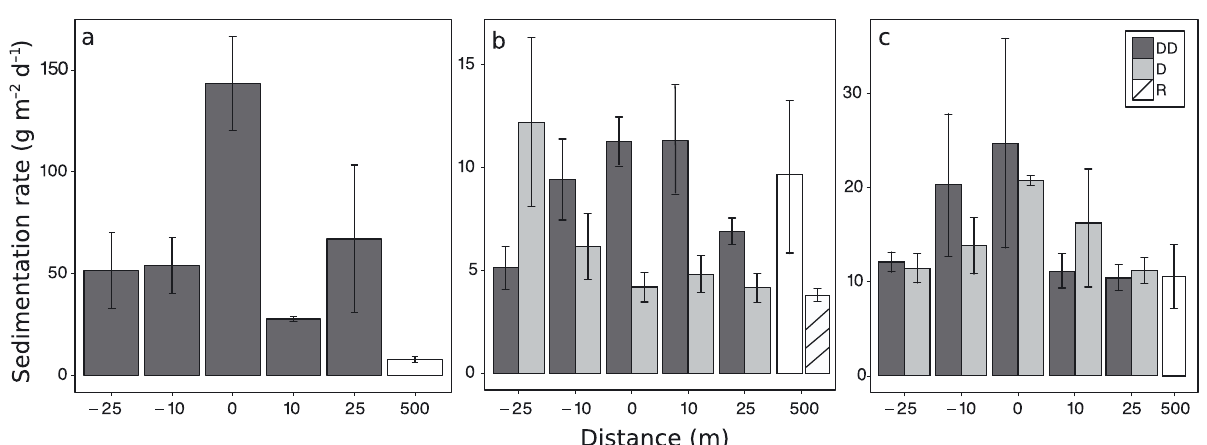
Fig. 2. Mean (±SE) sedimentation rate recorded in (a) June, (b) August and (c) October 2013 below and around mussel lines with 2 densities of mussels (DD: double; D: standard) and at the reference stations (R). References stations in August corre- spond to 2 sampling dates: 6−7 August (white), which were sampled simultaneously with stations under the D lines; stations under the DD line and R stations (with white stripes) were sampled on 14